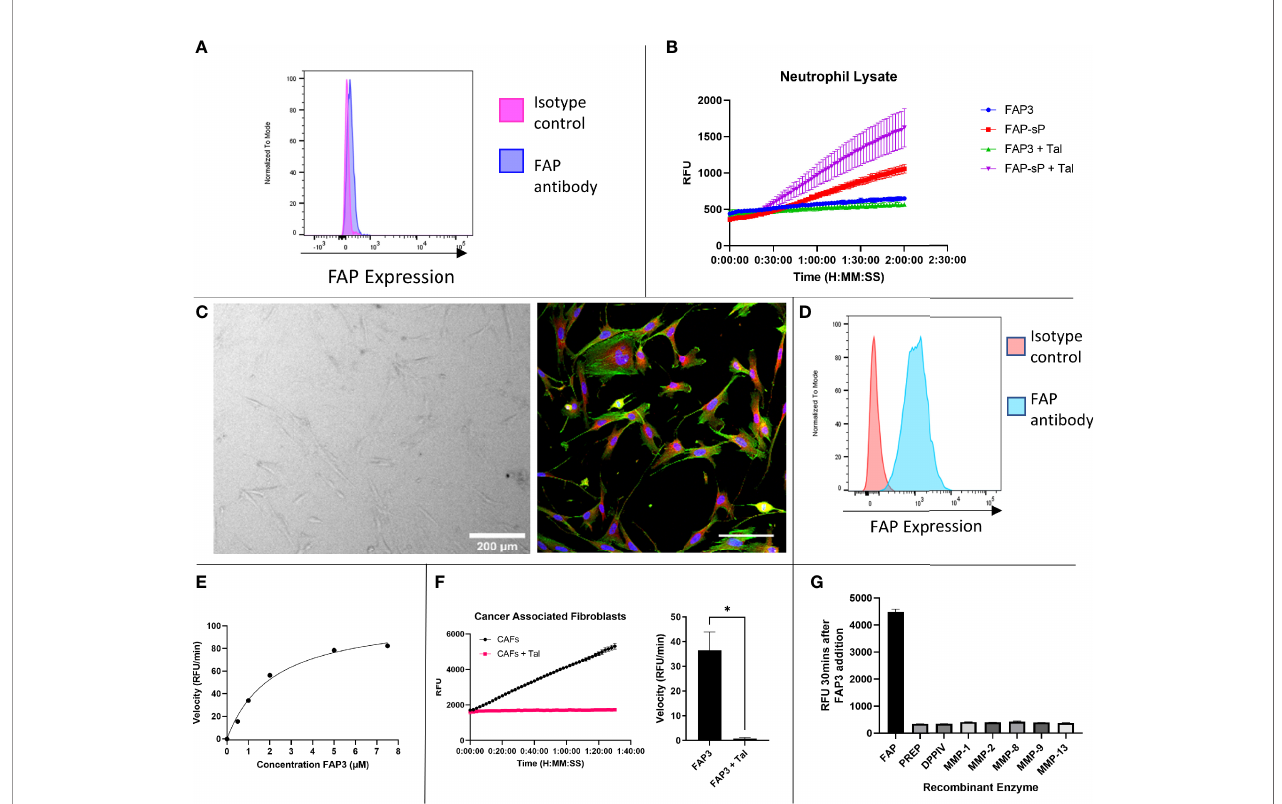
FIGURE 4 | FAP3 andFAP-sP probes assessedonactivated neutrophillysate and cancer associated fi broblasts (CAFs). (A) Flow cytometrycon fi rmed that neutrophils are FAP negative; (B) Assessment of FAP3 andFAP-sP inactivatedneutrophil lysate demonstratedcleavageof FAP-sP, including inthe presence of Talabostat (Tal), but no cleavage of FAP3; (C) Cancer associated fi broblasts in culture (bright fi eld, 200µm scalebar) andantibodystainedfor FAP (red), DAPI (blue) and phalloidin (green), scale bar 100µm; (D) Flow cytometrycon fi rmed CAFsare FAP positive; (E) Enzyme kinetics of usingvarying concentrationsofsubstrate FAP3 in presence ofrhFAP; (F) When incubated with CAFsFAP3 (5µm)was cleaved and signal was abrogated inthe presence of Talabostat; representative plotonleftandsum of n=3 with calculation ofvelocity inRFU/min shown on right.; (G) FAP3 demonstrates noactivity for other recombinant enzymes (MMPs) likelyto bepresent in NSCLC. n=2 for neutrophillysate testing and MMPtesting, n=3 for CAF testing, each experiment run in triplicate. Representative images shown*p<